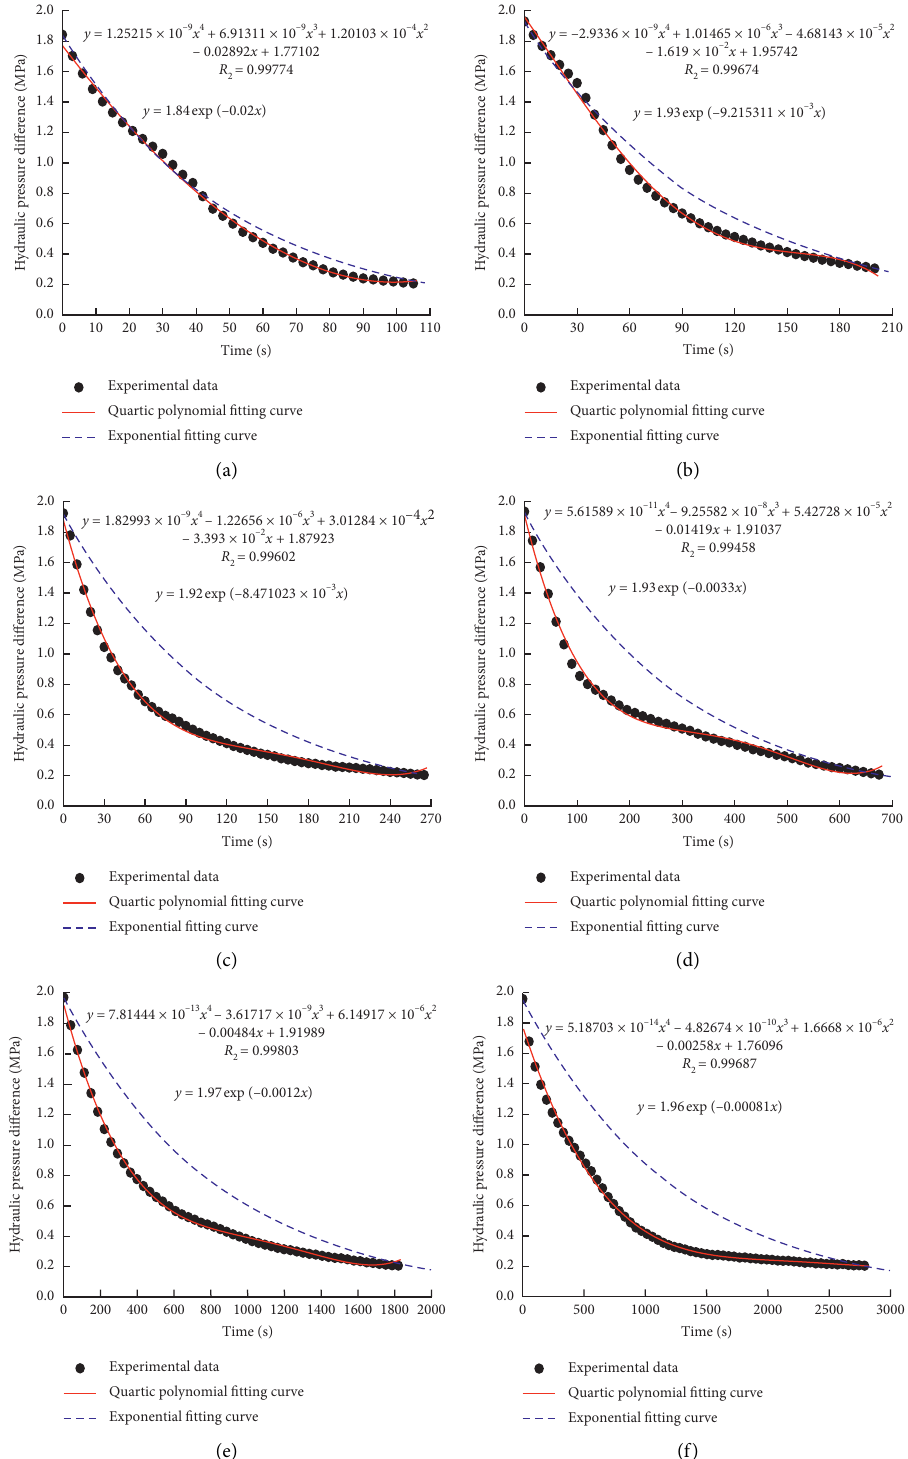
Figure 6: Hydraulic pressure decay-time data and the corresponding fitting curves for M07 specimen at a confining pressure of (a) 4MPa; (b) 6 MPa; (c) 8MPa; (d) 10MPa; (e) 12MPa; and (f)